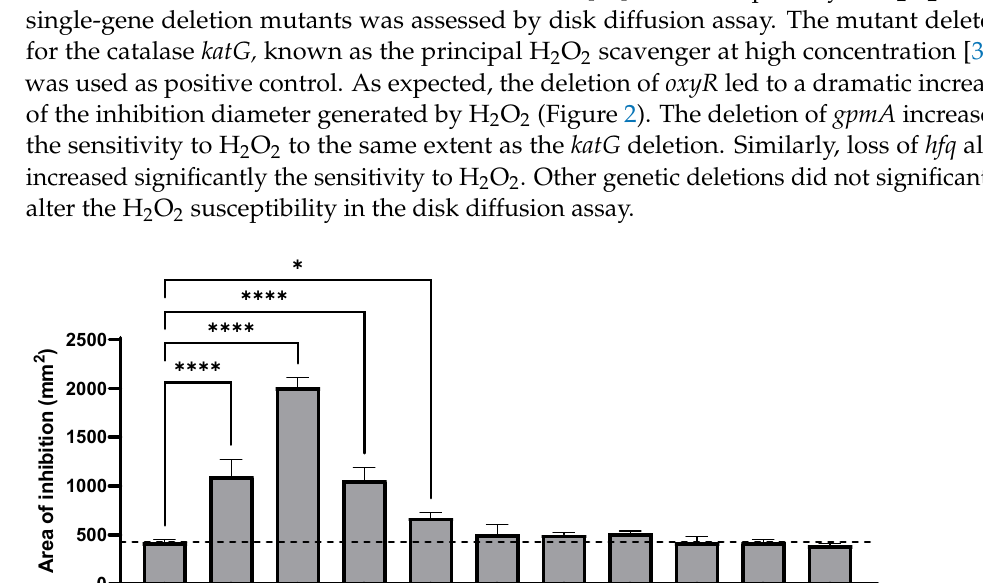
Table 3. Genes underrepresented in the H 2 O 2 condition of the TraDIS experiment. The gene function and the fold change compared to control are detailed.